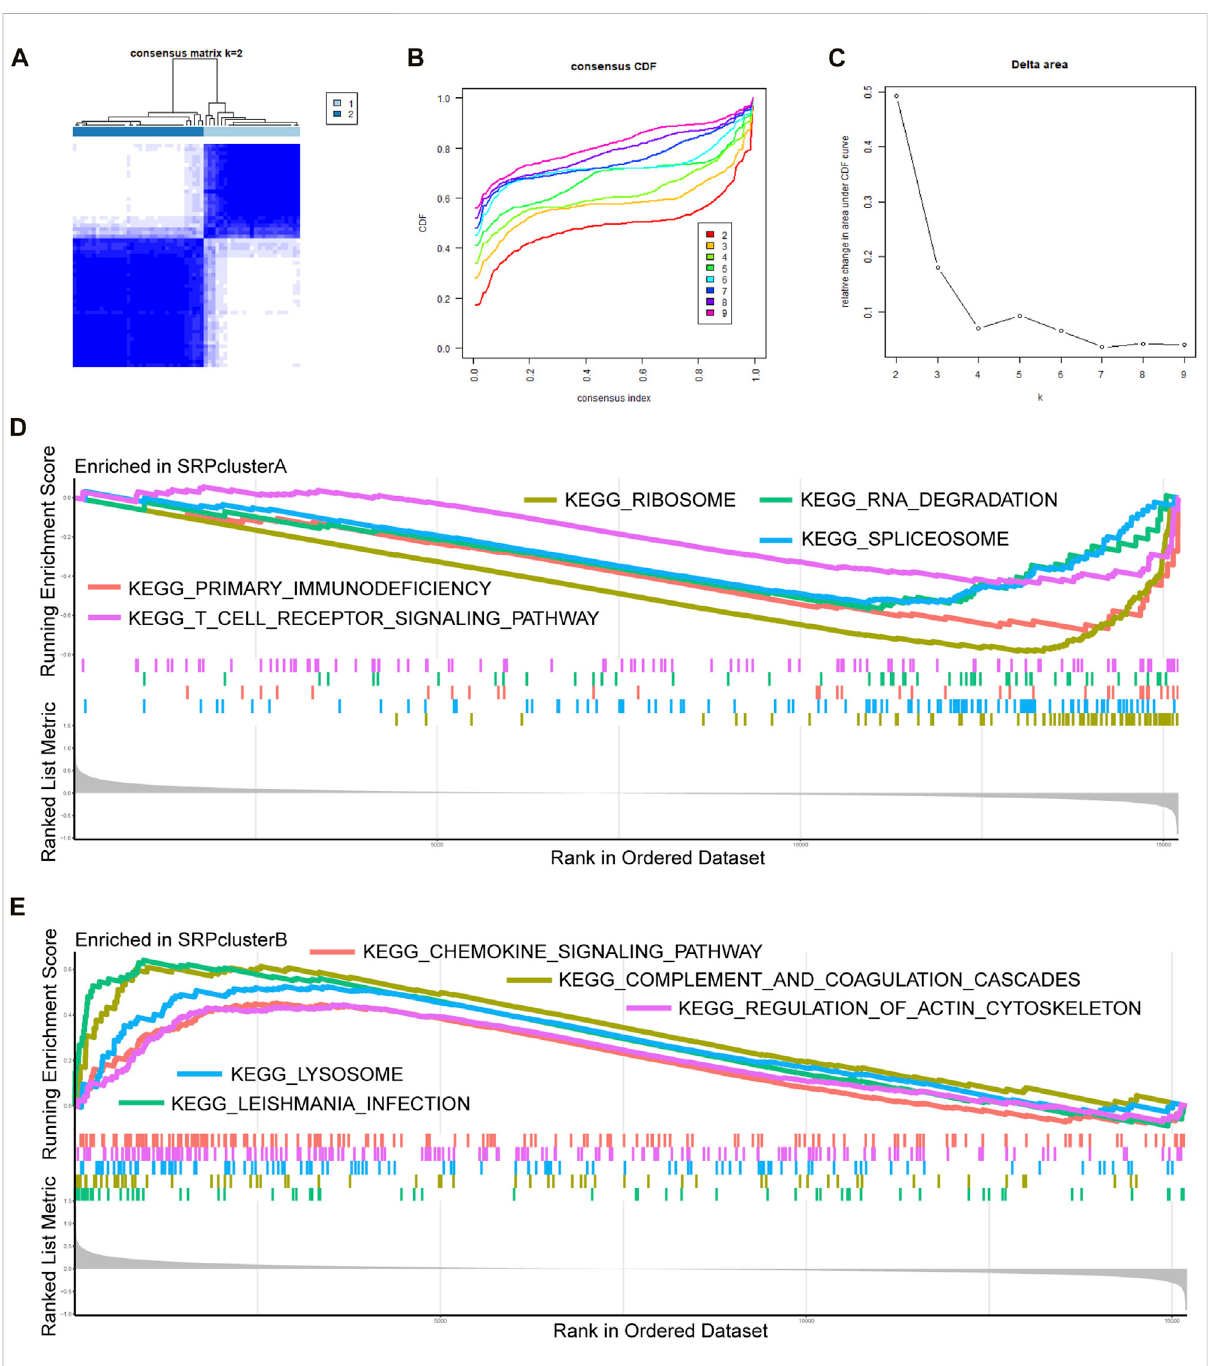
FIGURE 3 UnsupervisedclusteringandGSEA. (A) Consensusmatrix. (B) ACDFgraphillustratingtheclusteringaccordingtoDE-SRPGs. (C) Variationofthe area under the CDF curve for k = 2 – 9. (D) The top fi ve enriched KEGG pathways in SRPcluster A. (E) The fi ve most signi fi cantly enriched KEGG pathways in SRPcluster B. Adjusted p -value < 0.05 was taken as the criteria. Different colors represent different KEGG pathways, and the names of KEGG pathways are listed in the fi